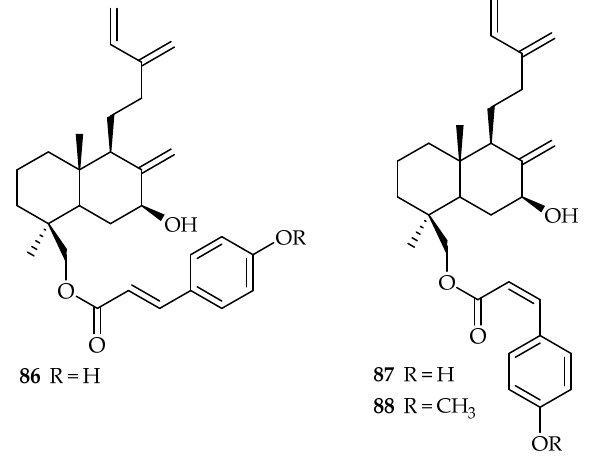
Figure 35. Structures of compounds 86–88